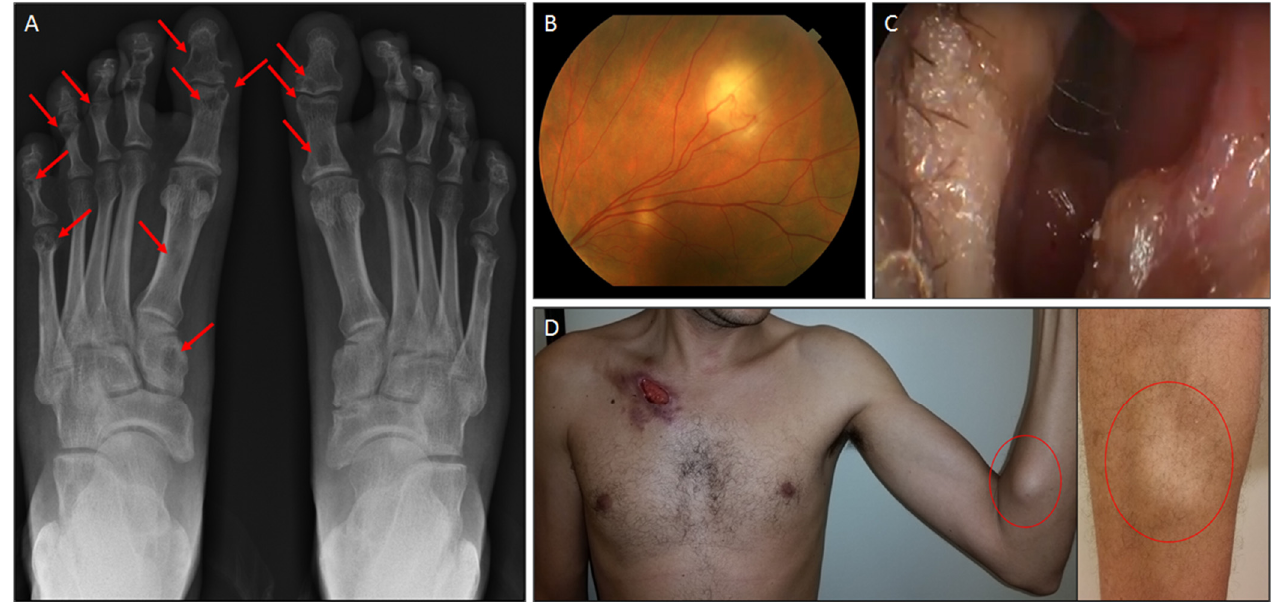
Figure 1. Sporotrichosis multifocal involvement. ( A ) Radiography of the feet of a 36-year-old man, with AIDS and low compliance to treatment. Several rounded to oval osteolytic lesions (red arrows point some) are seen on both feet. ( B ) Fundus image showing yellowish choroidal lesions. ( C ) Right nasal fossa-Infiltration in the right inferior turbinate head, nasal vestibule and superior septal region. ( D ) A 41-year-old previously healthy man with the cutaneous disseminated form of sporotrichosis. Ulcerated lesion surrounded by purplish lesions in the region of the right clavicle. Diffuse painless nodules/masses, here seen in the left forearm and in the right leg (red